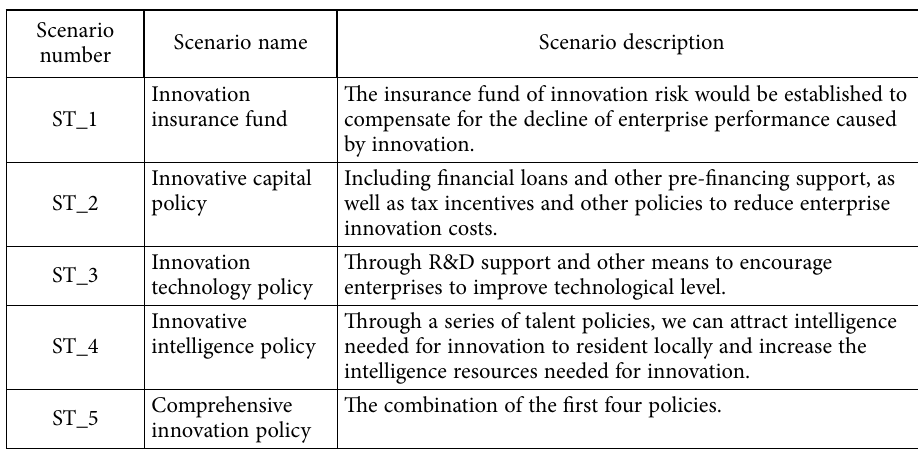
Table 3. Scenario Description of Innovation